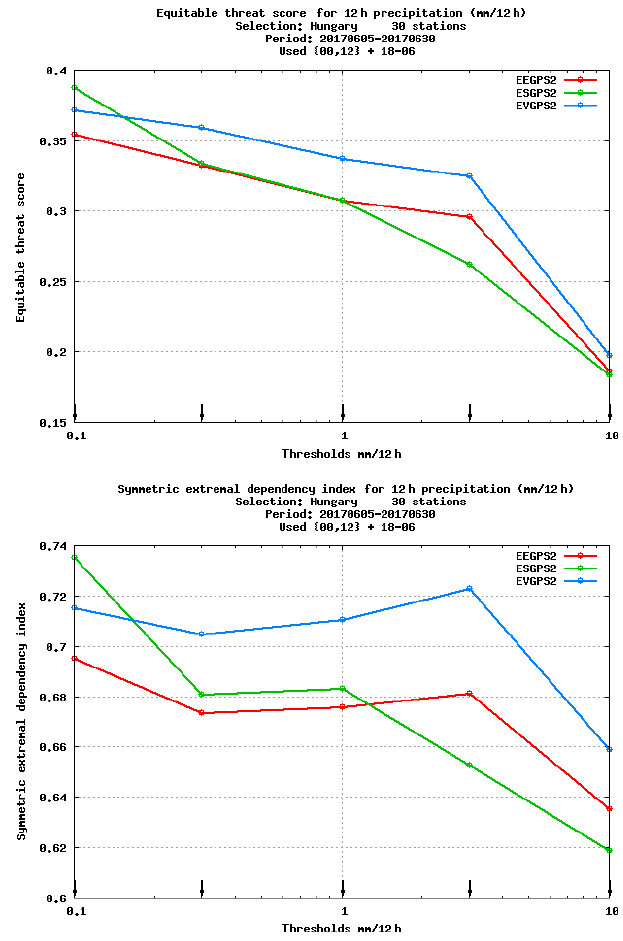
Figure 10. The ETS and SEDI scores of + 12h precipitation (12h accumulation) as a function of precipitation thresholds. Scores are visualised for experiments EEGPS2 (red), ESGPS2 (green) and EVGPS2 (blue). Verification period between 5 and 30 June 2017. Data selection: Hungary, 30